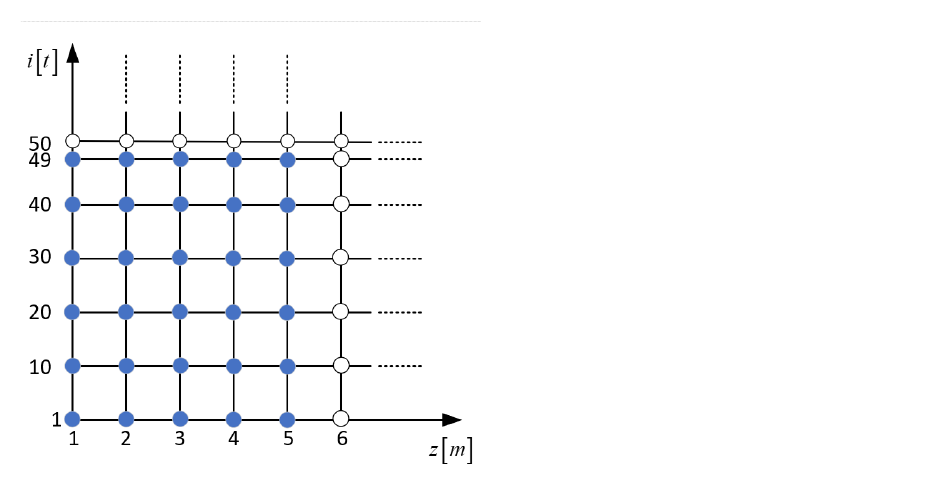
Figure 12. Grid representing the distribution of pollution excitations over length and time. The figure above illustrates the range over which pollution is maintained. The blue dots indicate the tenacity of the pollution over a given length at relevant moments in time, while the white dots are the beginning of the spread of the pollution. The simulation results are shown in Figure 13, and Table 5 summarises the values used.